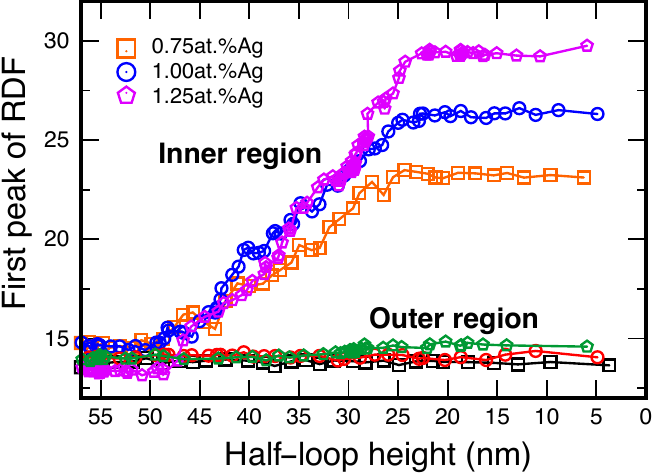
Figure 8. Change in the RDF’s first peak height (measure of the SRO) in the inner and outer rectangular regions shown in Figure 7 during the shrinkage of the inner grain. The results are shown for three alloy compositions indicated in the key at the temperature of 1000 K. Note that the SRO in the outer region changes very little, while the SRO in the inner region increases as the GB sweeps through its volume and levels out after the GB exits the